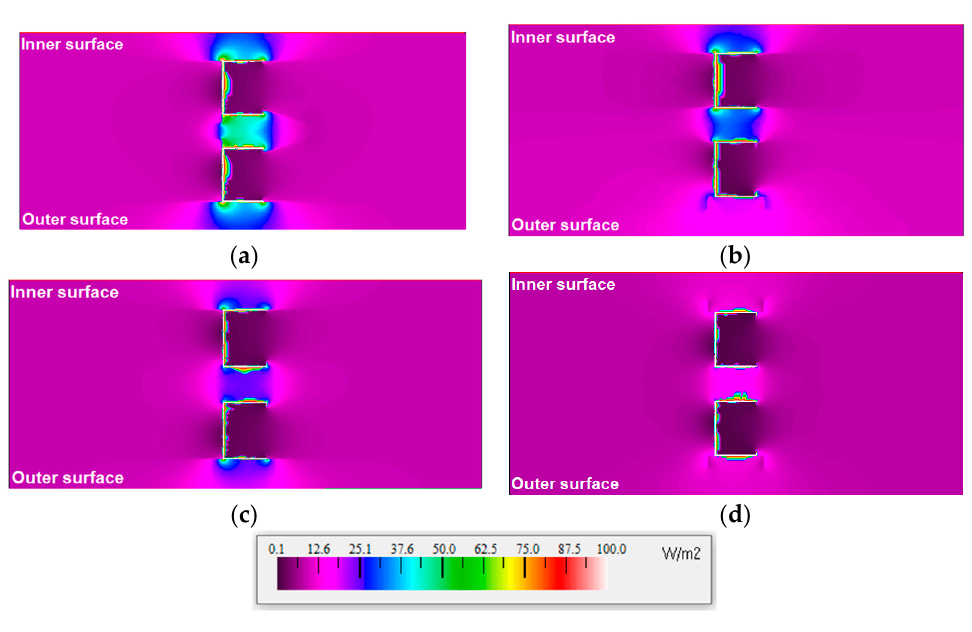
Figure 5. Predicted heat flux distribution within the LSF walls’ cross-section: ( a ) reference LSF wall; ( b ) outer TB strip; ( c ) outer AR foil; ( d ) double TB strips and AR foils. ( e ) color legend